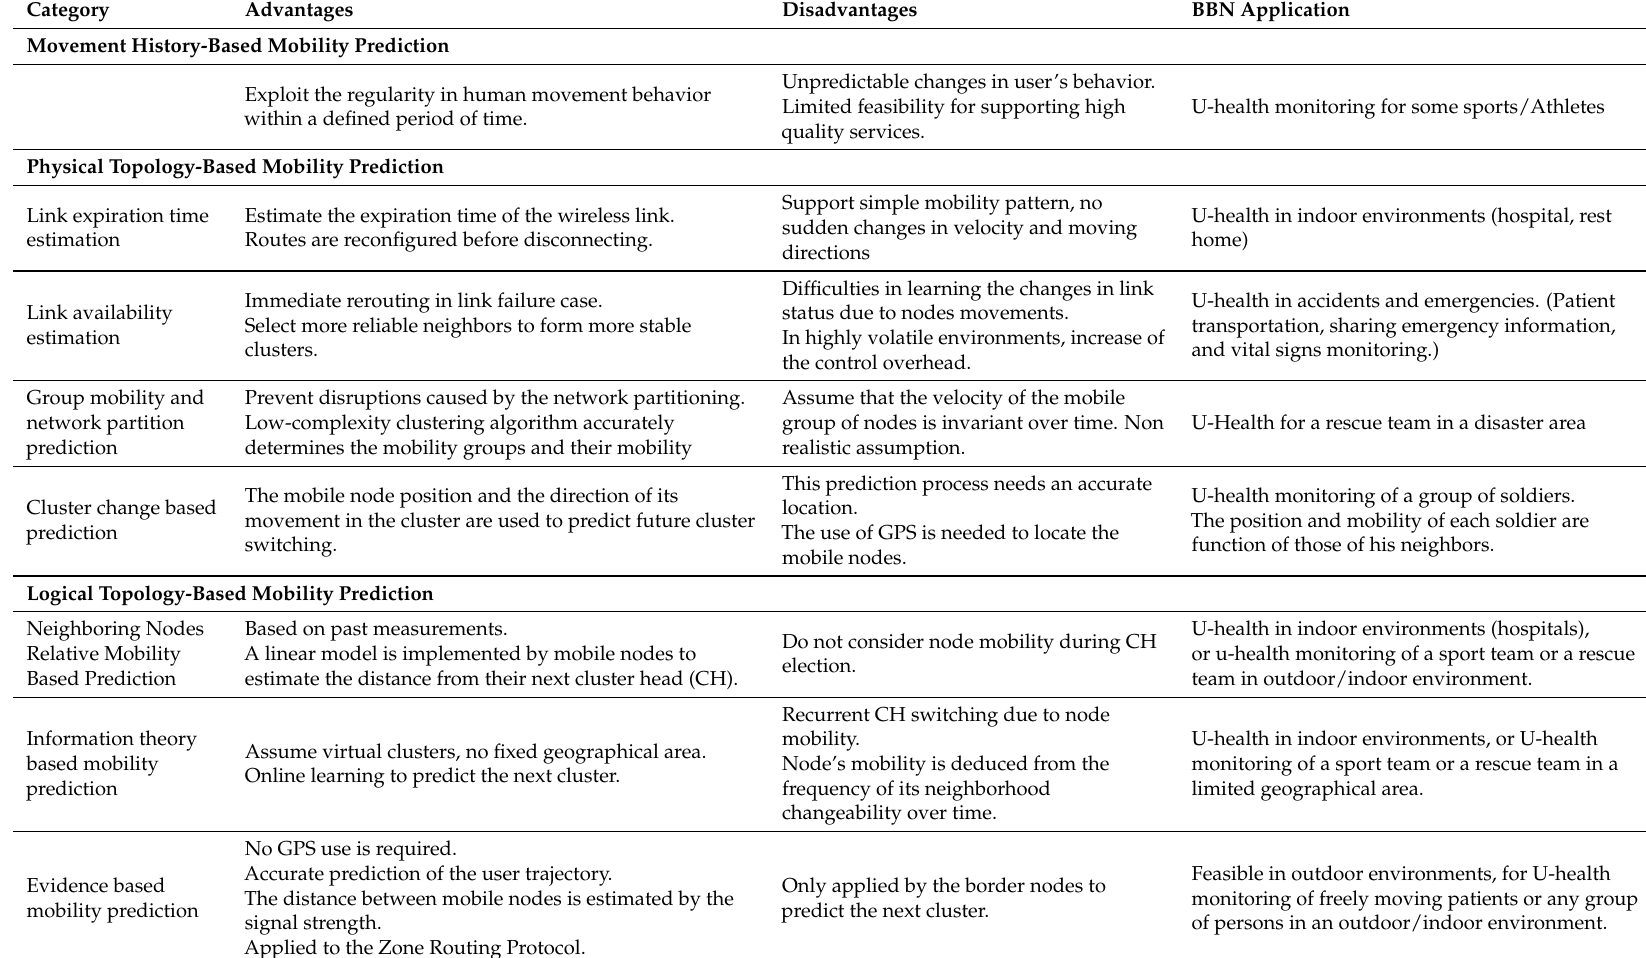
Table 2. Comparative study of mobility prediction methods for BBNs. c (cid:13) [2019] IEEE. Reprinted, with permission, from [4].